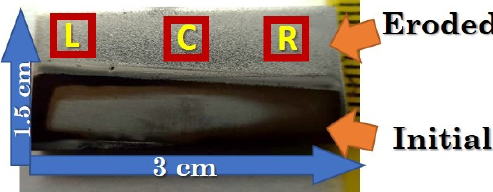
Figure 2. Example of Ar plasma exposed W plate; defining the measured regions.